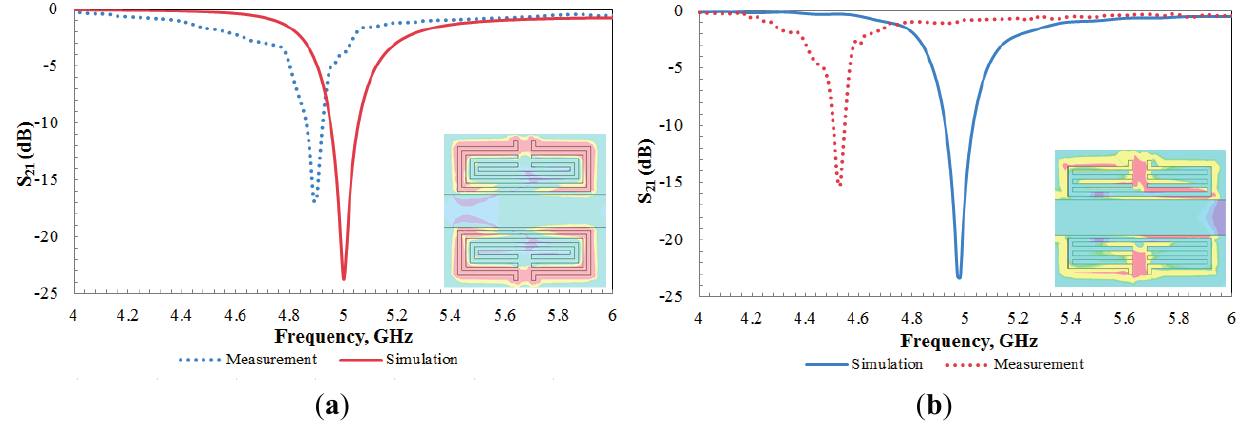
Figure 6. Simulated and measured S ( b ) centered-gap